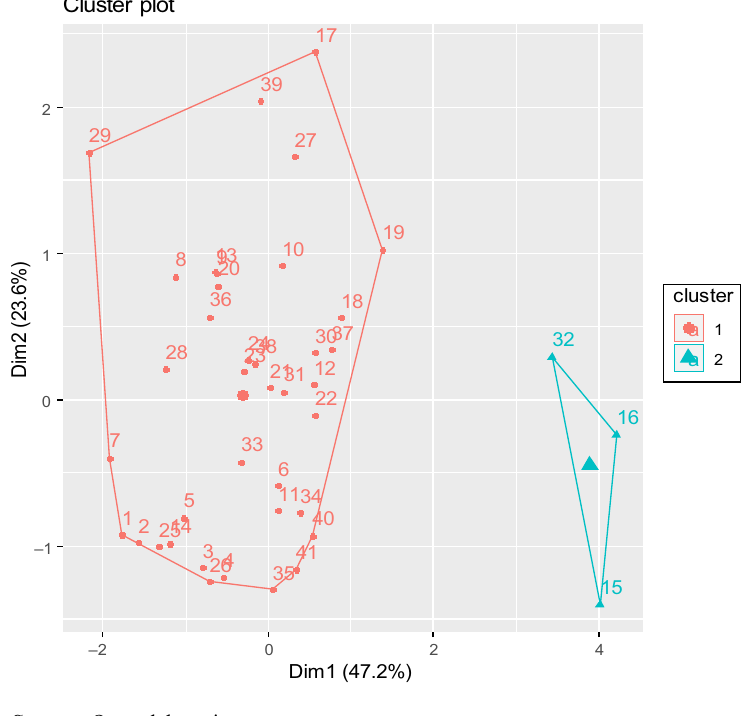
Figure 7. Scatter plot cluster